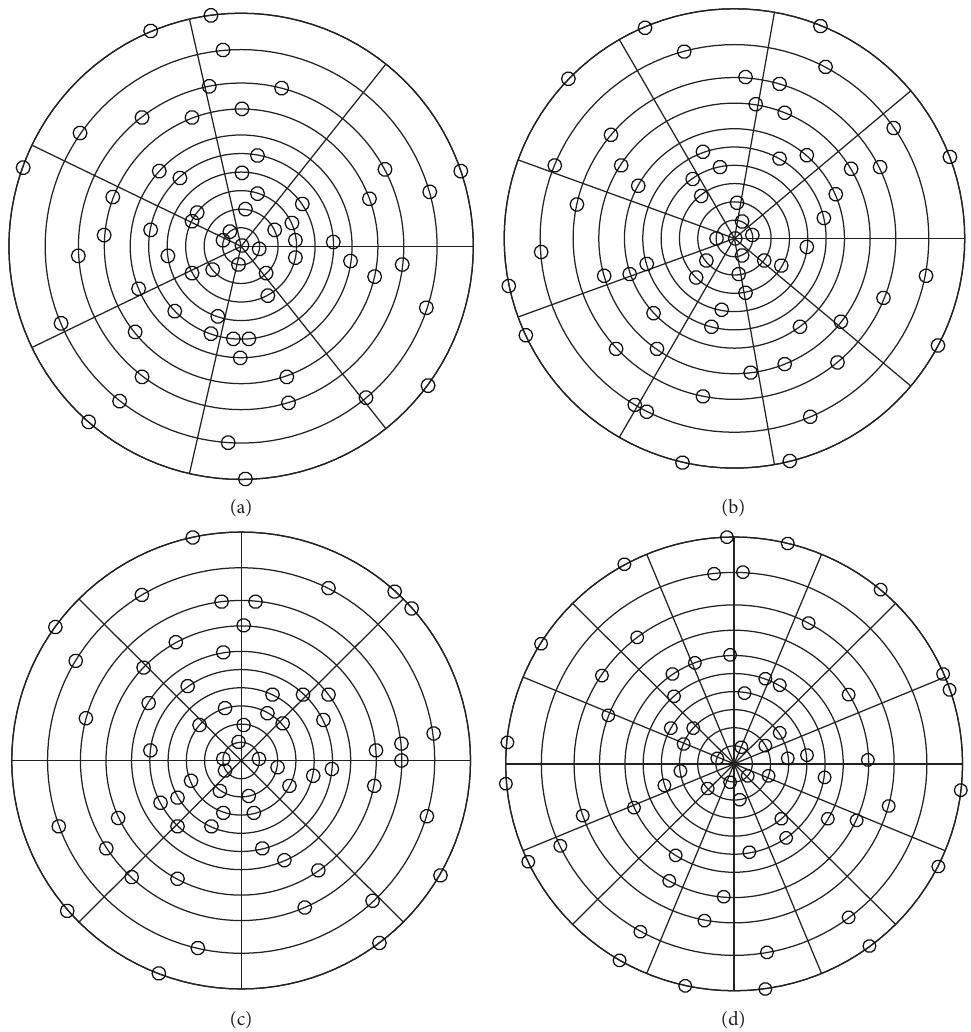
Figure 5: Partition configurations of 64-microphone array with different of subsection number C. (a) C � 7 and (b) C � 9 are with central microphone; (c) C � 8 and (d) C � 16 are without center